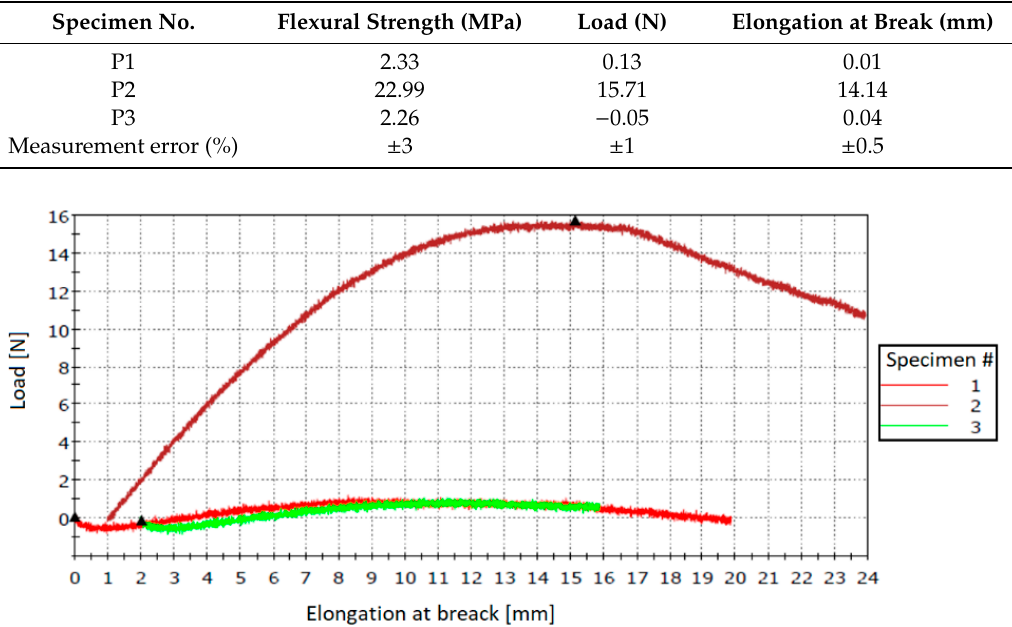
Table 8. Method 6 flexural test results for PUF-DCPD specimens.